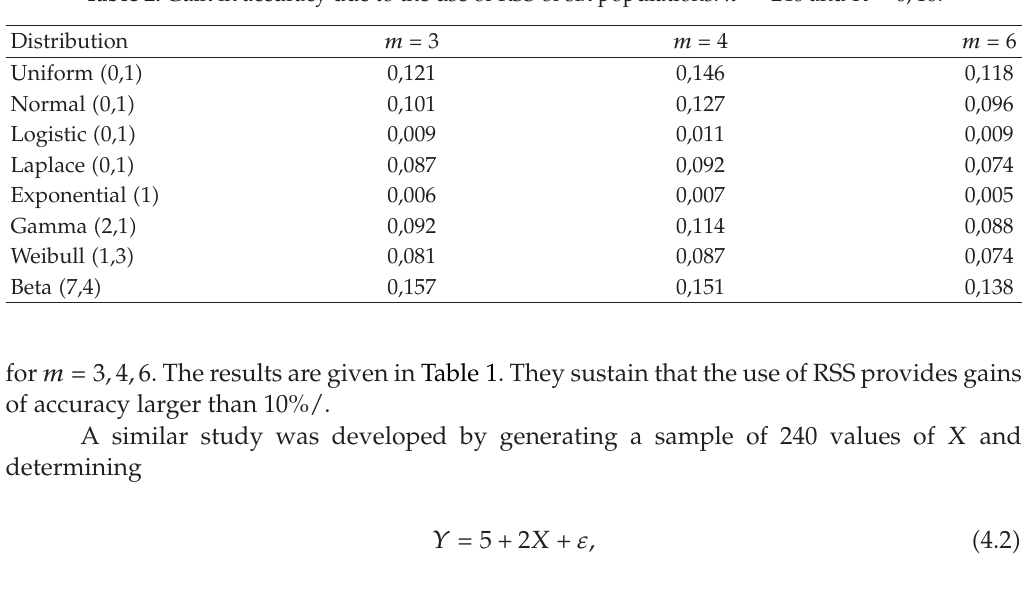
Table 2: Gain in accuracy due to the use of RSS of six populations: n ∗ (cid:2) 240 and K (cid:2) 0 ,